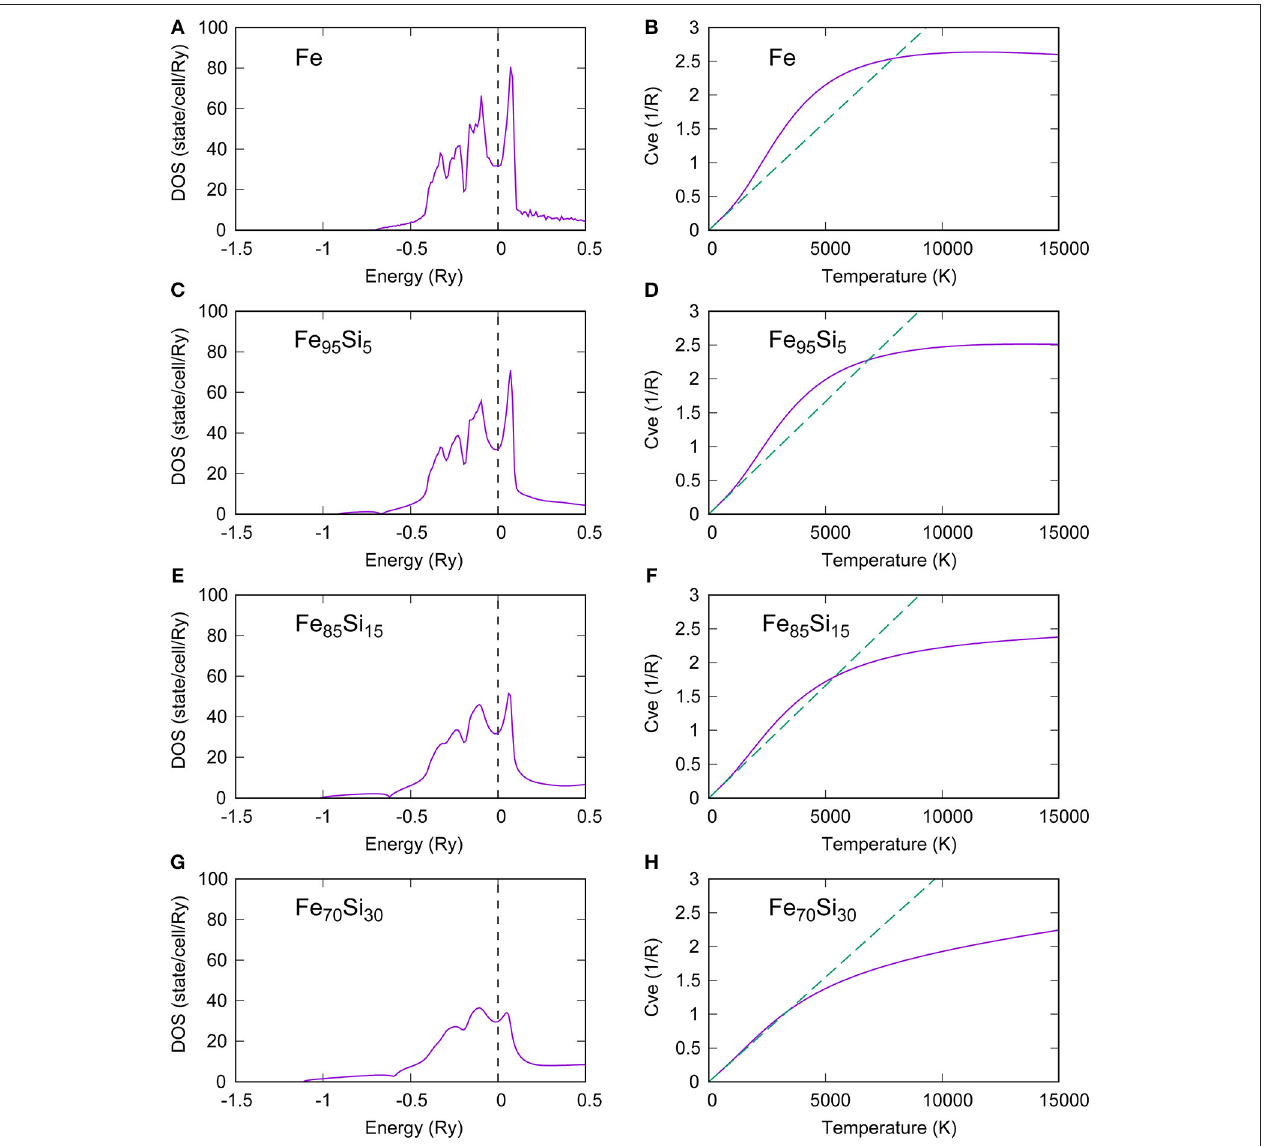
FIGURE 7 | Density of states (DOS) (A,C,E,G) and corresponding electronic specific heat (B,D,F,H) . Green broken lines represent the electronic specific heat obtained from the Sommerfeld